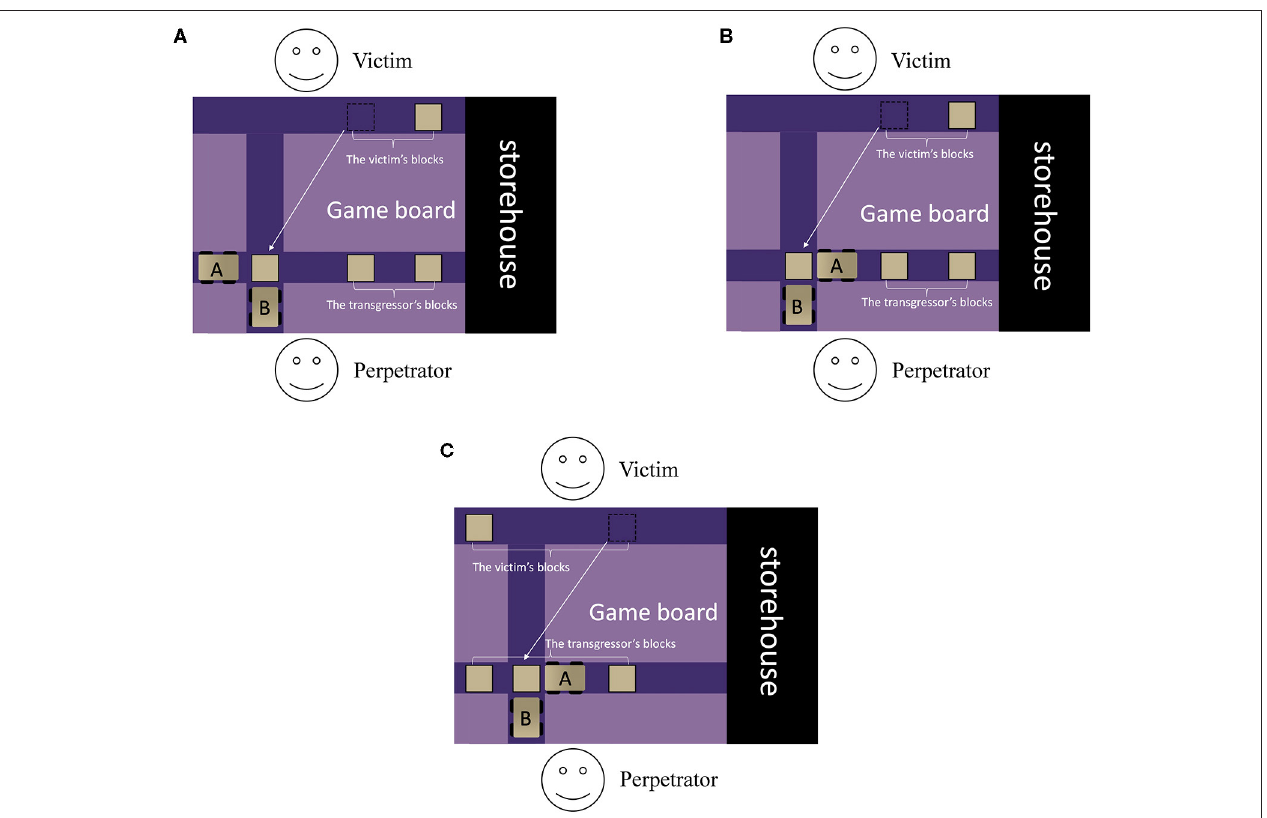
FIGURE 1 | The arrangement of the game board in three experiments (see online version for the colored version of this figure). (A–C) represent the experimental set-up in Experiments 1, 2, and 3, respectively. The victim (top) owns the blocks (represented by white squares in the figure) on the upper horizontal lane, while the perpetrator (bottom) owns the blocks on the lower horizontal lane. There are two cars (shaded gray rectangles with four black “wheels”); these cars can move on the dark purple lanes that they are located at. Car A is on the lower horizontal lane and can move toward the “storehouse” on the right side, whereas Car B is on the vertical lane and moves upwards toward the upper horizontal lane. The white arrows illustrate the relocation of the victim’s block caused by the perpetrator. The difference among the three experiments is the number of blocks that Car A can push to the storehouse. In Experiment 1 (A) , Car A can push 3 blocks to the storehouse, thus the perpetrator has no blocks left. In Experiment 2 (B) , Car A can push 2 blocks to the storehouse, thus the perpetrator has 1 block left. In Experiment 3 (C) , Car A can push 1 block to the storehouse, thus the perpetrator has 2 blocks